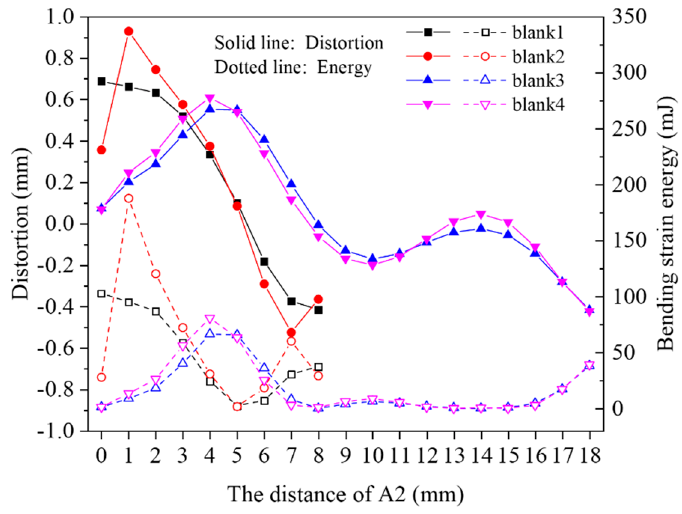
Figure 11. The distortion of part 1 in different blanks.